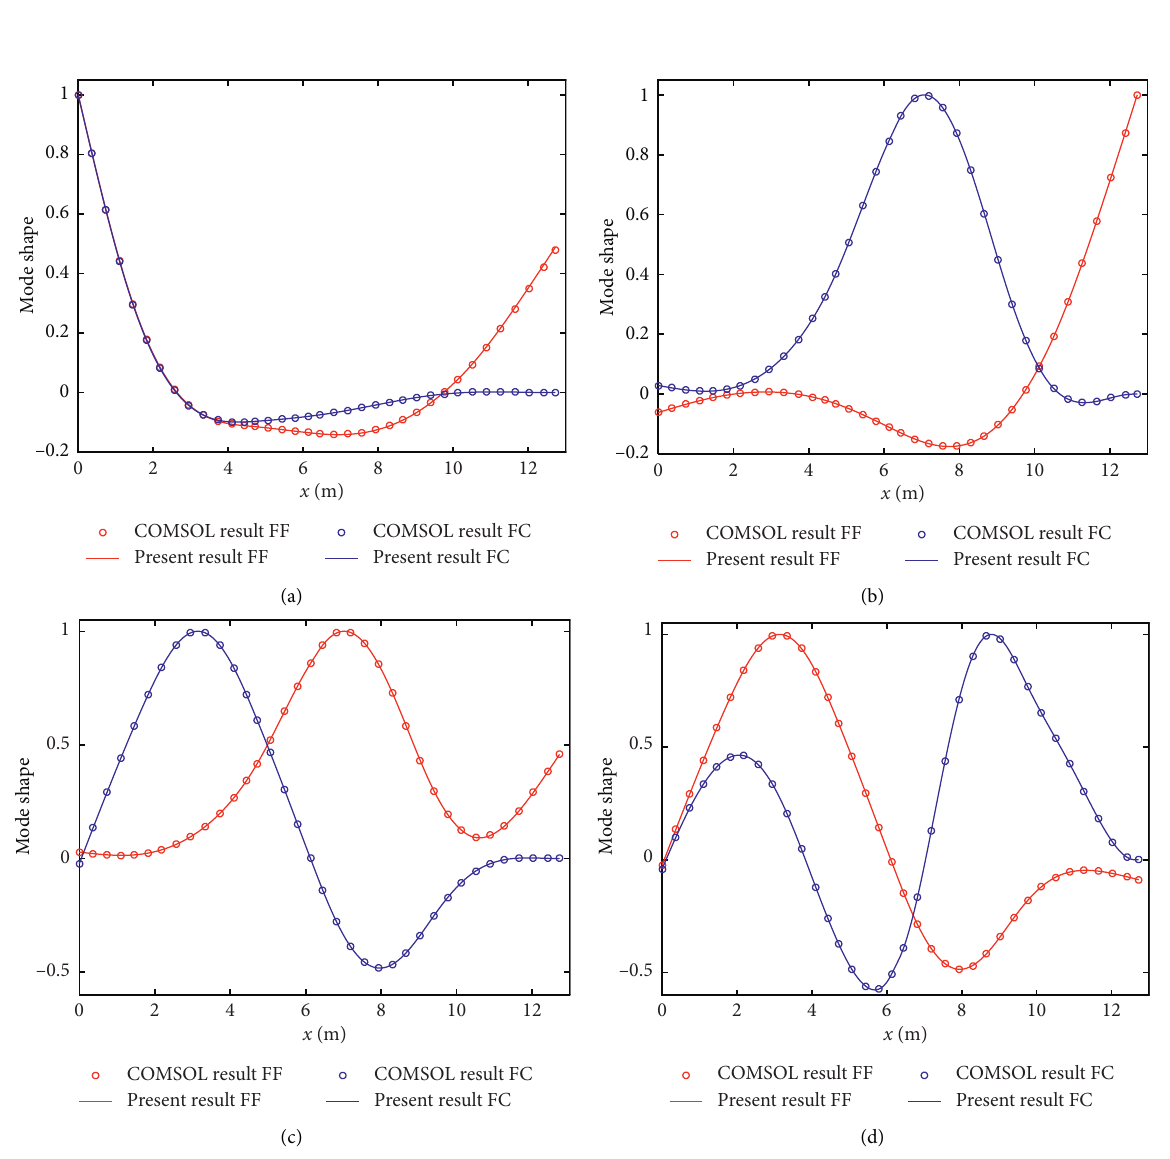
Figure 4: The first four mode shapes under F-F and F-C boundary conditions. (a) Mode shape 1. (b) Mode shape 2. (c) Mode shape 3. (d) Mode shape 4.